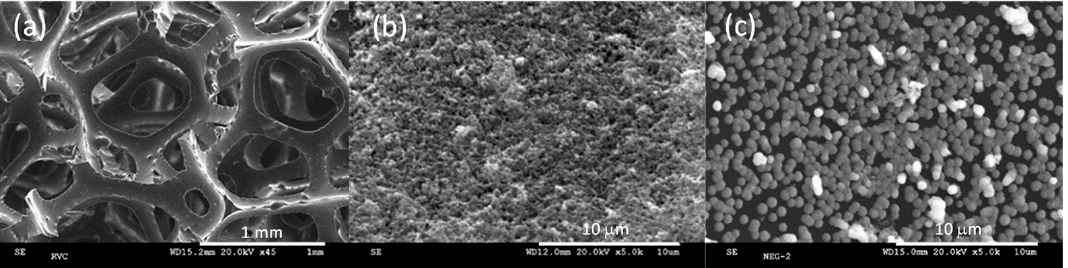
Figure 2. SEM images of studied cathodes: ( a ) 60 ppi raw RVC; ( b ) RVC dip coated; ( c ) RVC gal-vanostatically coated.